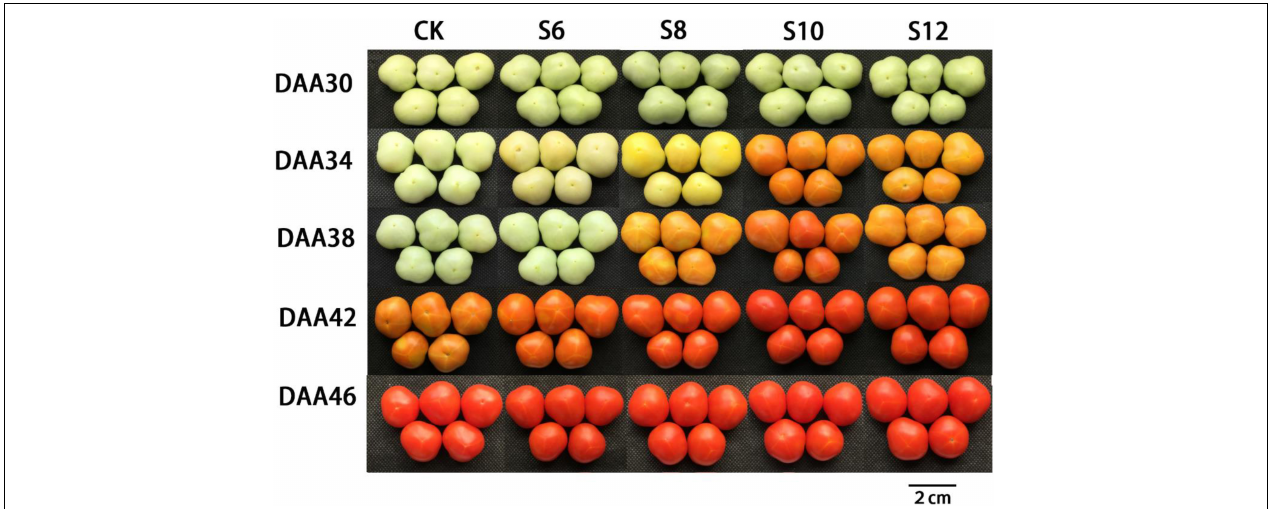
FIGURE 2 | Changes in fruit characteristics during tomato ripening under different stage and different supplemental blue light